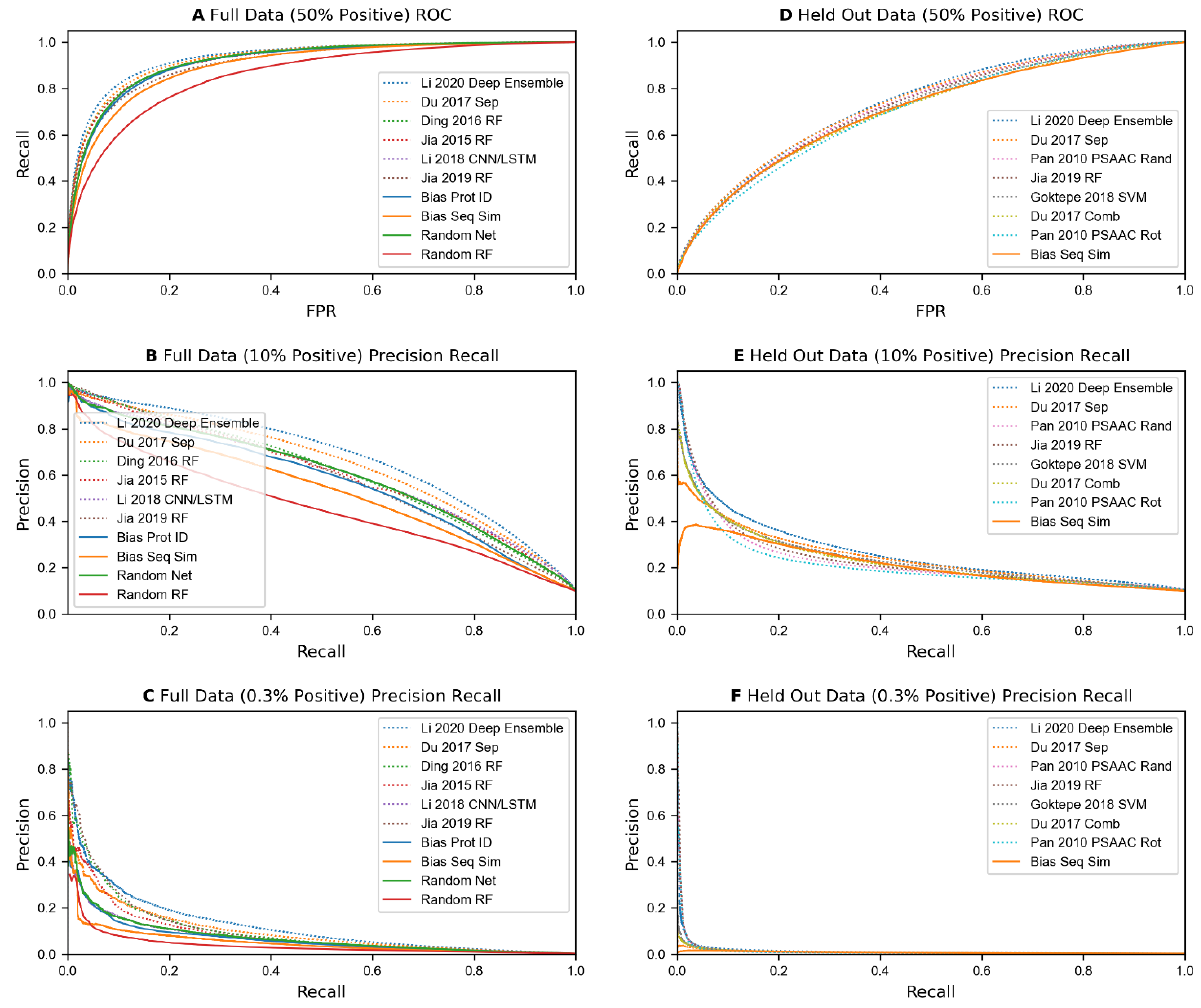
Figure 2. ( A – C , left ) Results when selecting from the full set of protein pairs for training and testing for a handful of the best algorithms (dotted lines) and the 4 illogical feature-based algorithms (solid lines). ( A ) ROC curve with 50% positive data. ( B , C ) Precision-Recall curves using 10% and 0.3% positive data in the test set. ( D – F, right ) Computations when performed on held out proteins instead of selecting from the full set of pairs. When holding out protein pairs, the algorithms exhibit a significant performance drop. Additionally, the algorithms and bias measurements score similarly across all 6 tests. Table 3. Datasets reported in prior publications. The original publications that created these datasets are referenced in the first column. The next two columns report the species of the data and the publications that report PPI prediction accuracies on these data. The data sizes (number of PPIs are number of unique proteins) are reported after mapping protein names to UniProt and filtering to remove proteins shorter than 31